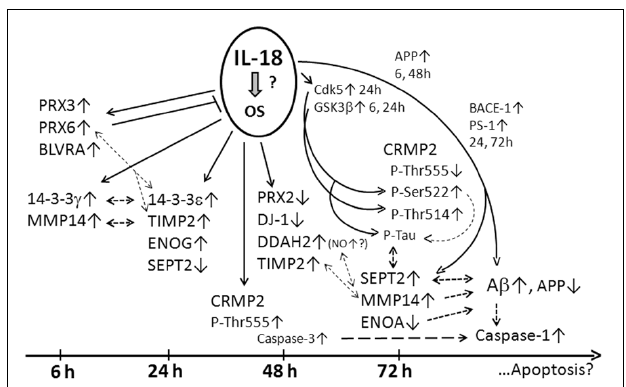
FIGURE 6 | Summary figure of the WIB results. IL-18 may induce OS due to increase of antioxidative PRX3 , -6, and BLVRA in SH-SY5Y cells. 14-3-3 γ (modulator of apoptosis; intracellular trafficking; cell cycle control; signal transduction; and metabolism), 14-3-3 ε (anti-apoptotic; a component of the prion/amyloid deposits of Gerstmann-Straüssler-Scheinker disease). 14-3-3 ε can bind PRX6, translocating PRX6 to lysosomes when MAPK